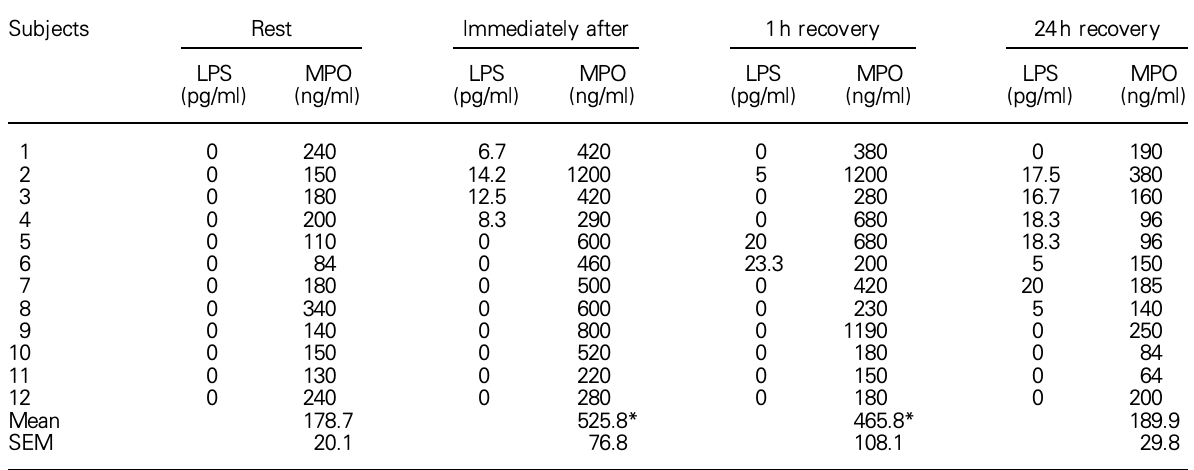
Table 1. Plasma levels of lipopolysaccharide (LPS) and granulocyte myeloperoxidase (MPO) measured in 12 subjects before and after a quarter triathlon